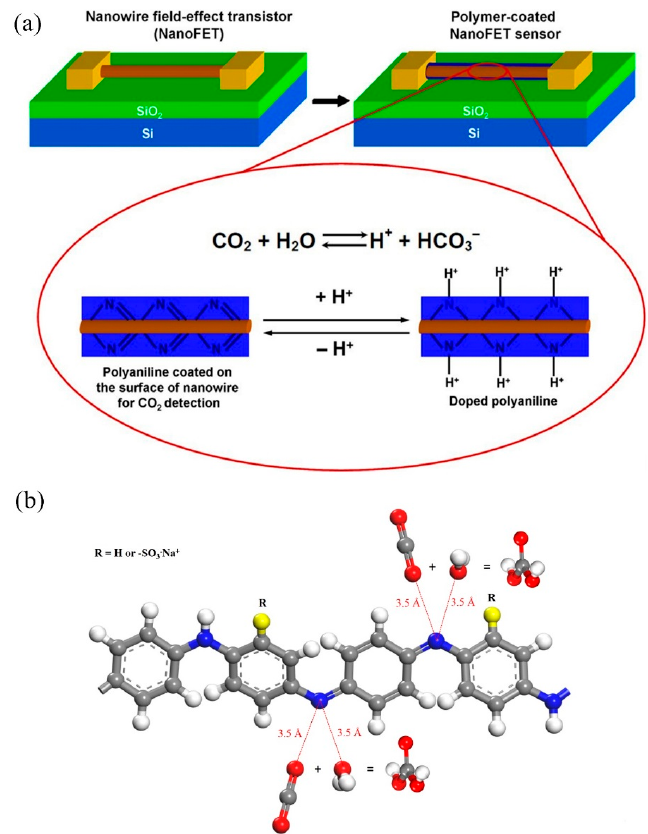
Figure 1. ( a ) schematic diagram of sensing mechanism of an example polyaniline (PANI) coated nanowire field-effect transistor (NanoFET) as CO 2 sensor; ( b ) examples of CO 2 react with H 2 O adsorbing in the sites of PANI to form H 2 CO 3 .